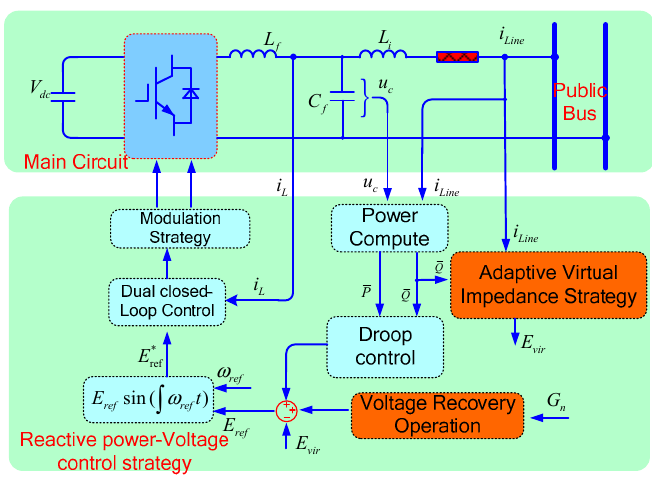
Figure 5. Simulink scheme of the single DG unit. Table 1. The circuit and control parameters of the DG unit.